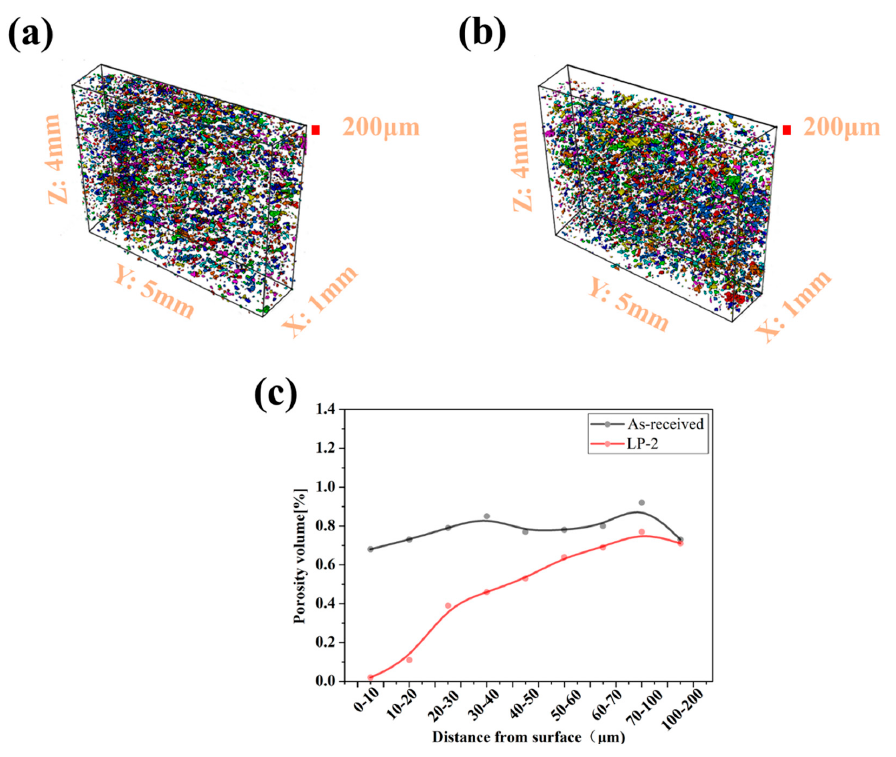
Figure 5. ( a ) The reconstructed false-color image of the as-received sample, ( b ) The reconstructed false-color image of the LP-2 sample, and ( c ) the porosity volume from different distances to the surface for the as-received and LP-2 samples. (The red shows the extension of the area analyzed).